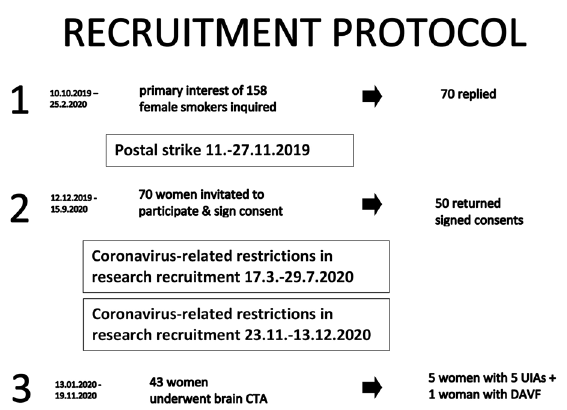
Figure 1. Schematic figure of the UIA screening -pilot study recruitment